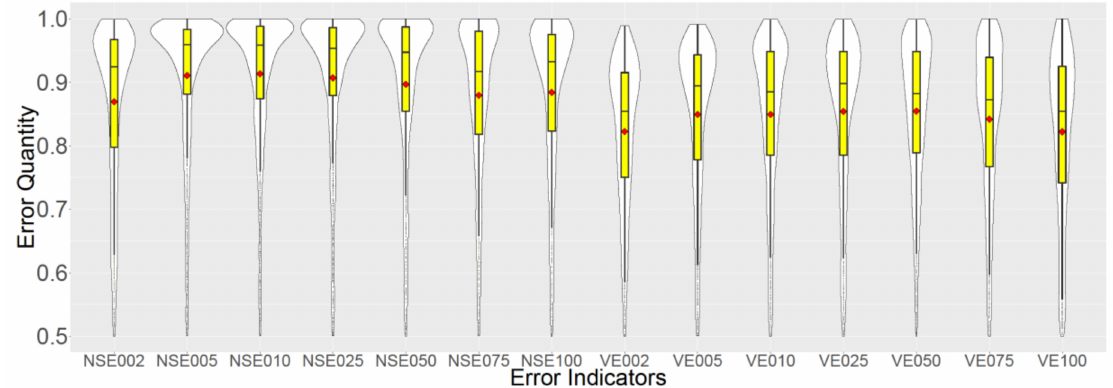
Figure 6. Effect of reducing the training dataset size on emulator training time (how long it takes to train the emulator) and acceleration factor (how many times is the emulator faster than the simulator).